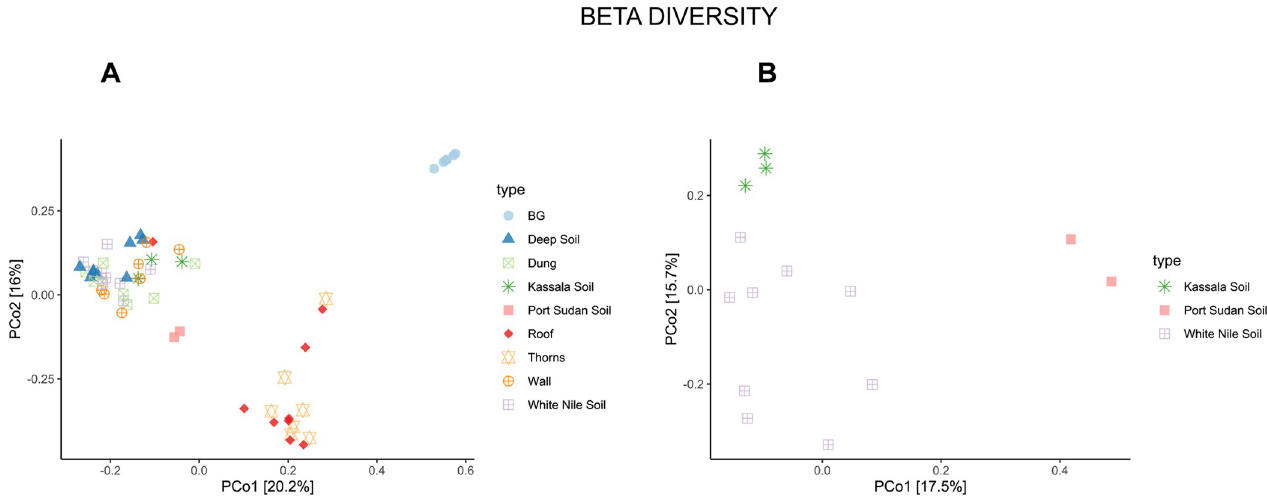
Fig 3. Beta diversity calculated as unweighted UniFrac and represented as a Principal Coordinates Analysis (PCoA) of all samples (a) and endemic and non- endemic soil samples (b).